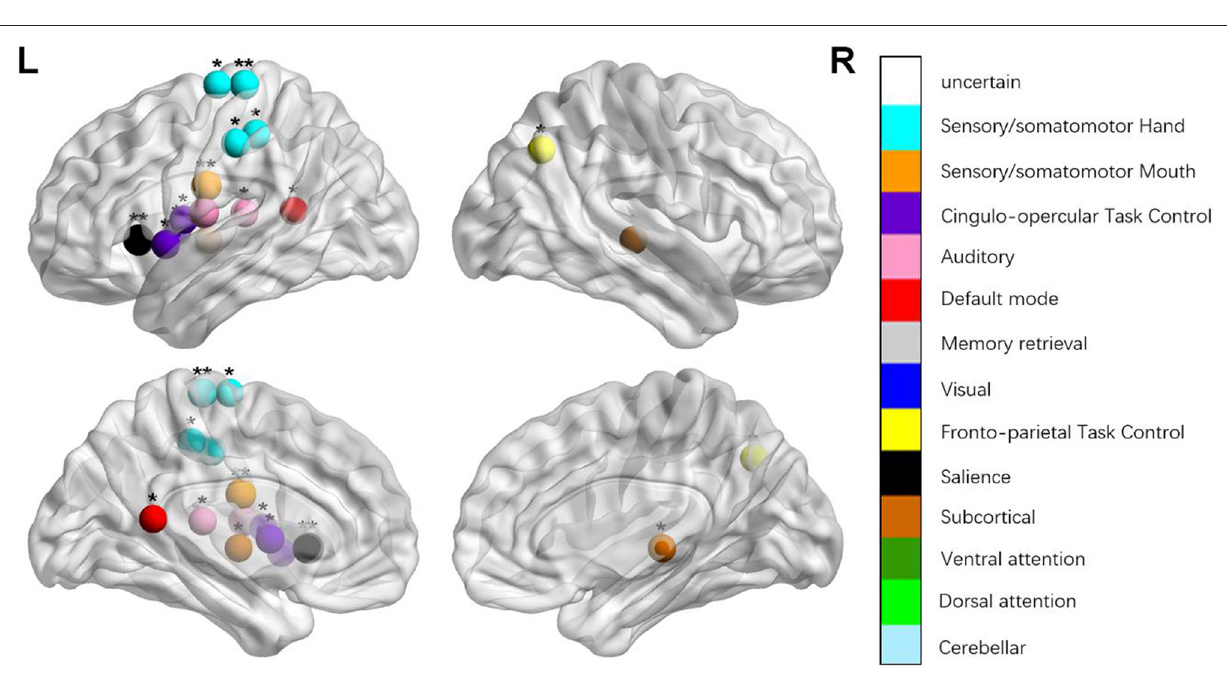
FIGURE 2 | Regions were considered an abnormal nodal degree in patients with aphasia if they exhibited significant between-group differences. * p < 0.003787, Bonferroni correction (i.e., 1/264). ** p < 0.000189, Bonferroni correction (i.e., 0.05/264). used. The results of segmentation were visually checked by normalization with a 6-tissue parameter rather than traditional the authors to ensure their correctness. Then, all resting-state lesion-masked normalization (Rorden et al., 2012) to get a better functional images for each individual were co-registered to result. For the controls, the common SPM New Segment was